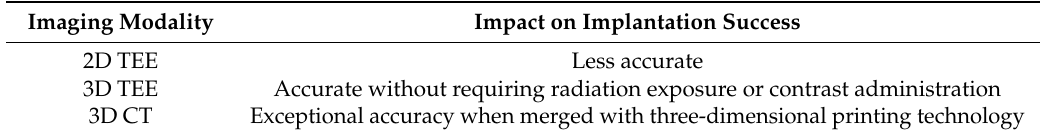
Table 6. Preprocedural imaging impact on predicting the correct size of the WATCHMAN device.